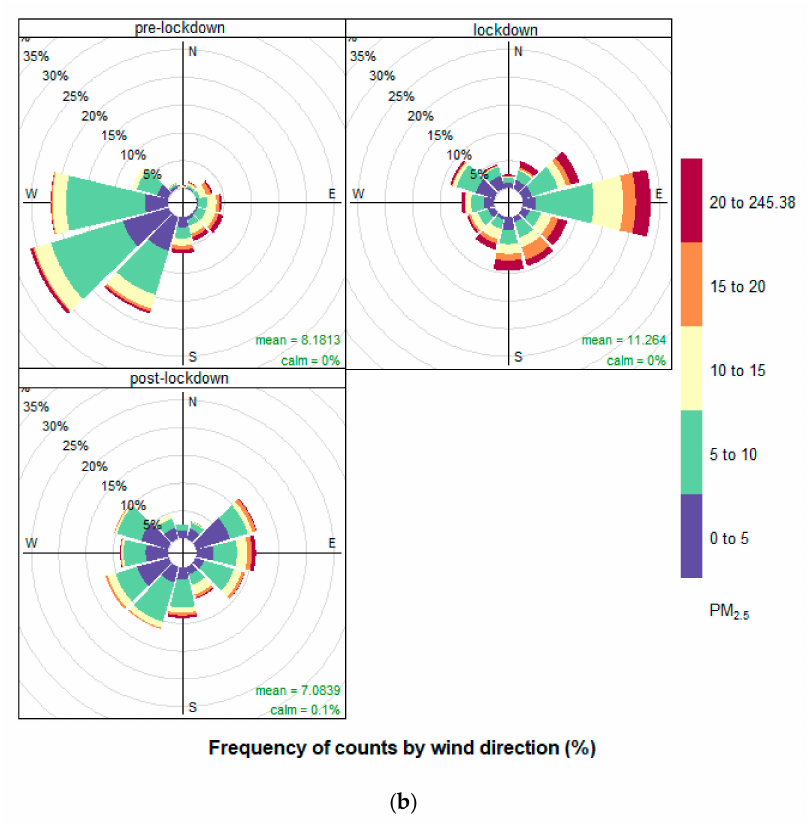
Figure 6. Pollution roses demonstrating how weather conditions changed during the three periods: changes in temperature linked with wind speed and directions ( a ); changes in PM 2.5 linked with changes in wind speed and directions at the Manchester Piccadilly site ( b ).